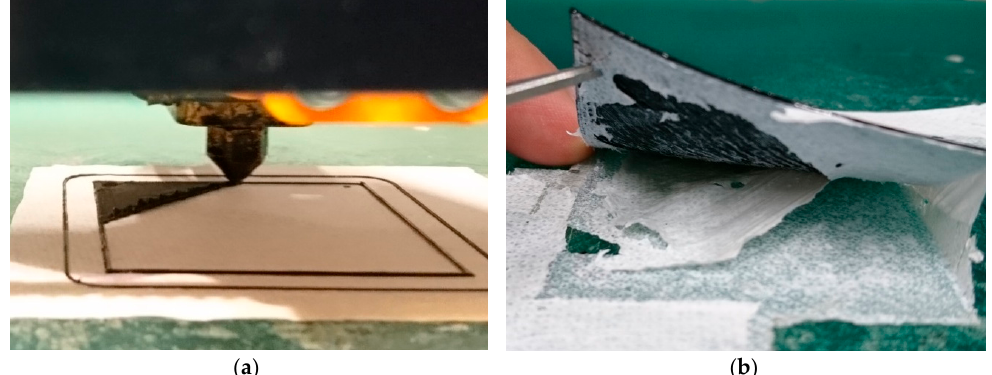
Figure 2. 3D printing squares of dimensions 40 mm × 40 mm on nanofiber mats: ( a ) rough surface for